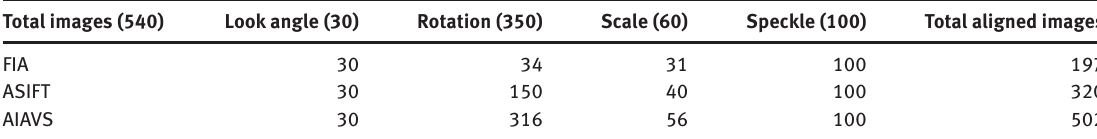
Table 3: Quantitative Assessment of the AIAVS Approach: Total Number of Aligned SAR Images Deformation Wise. Total images